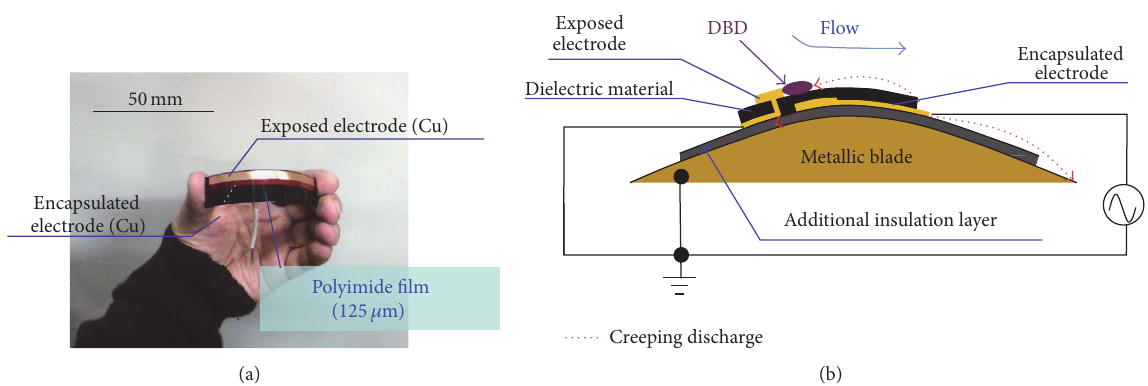
Figure 1: Conventional sheet-type DBD plasma actuator. (a) Picture of sheet-type DBD plasma actuator; (b) an illustration of technical problems for use of sheet-type DBD plasma actuator in actual